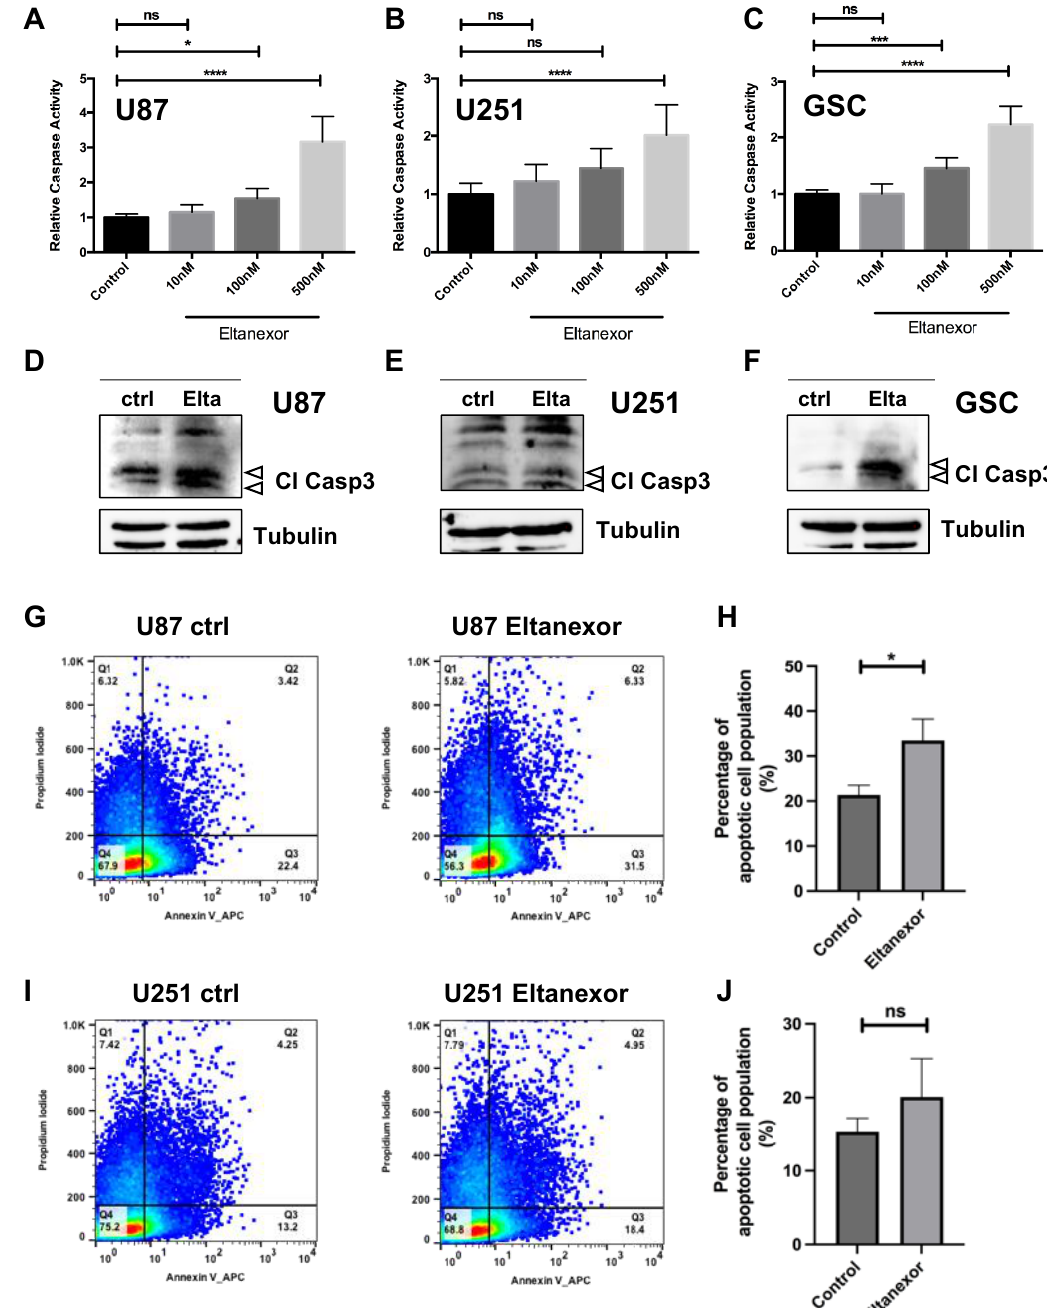
Figure 2. Detection of apoptosis in GBM cell after treatment with Eltanexor. A-C, caspase activities determined by Caspase GLO™ assays after treatment with 10, 100, and 500 nM Eltanexor for 24 h in U87 ( A ), U251 ( B ), and for 48 h in patient-derived GSCs 74 ( C ) compared to solvent DMSO (“ctrl”). All values are based on triplicate measurements performed in three independent experiments. Activities are shown relative to the control condition (set to 1) with relative changes given. ( D – F ), Western Blot to detect cleaved caspase-3 after treatment with 500 nM Eltanexor. Bands representing cleaved caspase-3 are marked by arrowheads (19 and 17 kD). ( G – J ), Representative Annexin V staining in U87 ( G , H ), and in U251 ( I , J ) cells as determined by FACS analyses. ( H , J ), Quantitative evalu- ation of annexin V staining from 3 consecutive experiments after treatment of either U87 ( H ) or U251 ( J ) cells with Eltanexor. Values are shown as mean values ± S.D. Significance was determined by one-way ANOVA with *, p < 0.05, ***, p < 0.001, and ****, p < 0.0001.